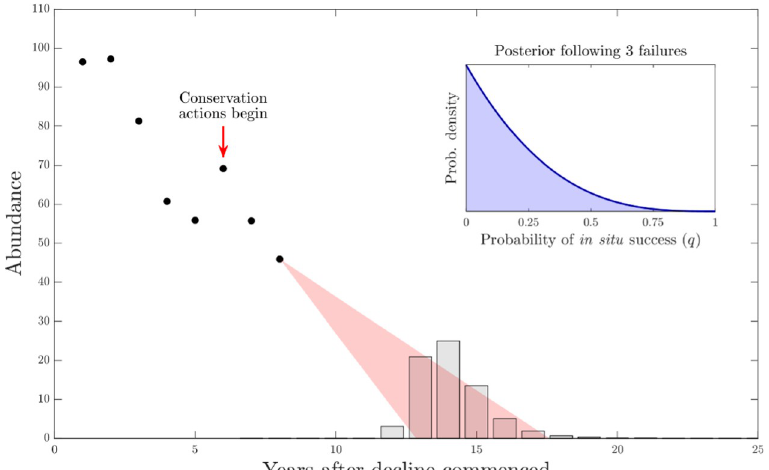
Fig 1. Schematic of an ex situ , in toto decision for a hypothetical single population threatened species (SPTS). The SPTS abundance has been observed to decline at a linear rate for 8 years; extrapolating, the population will likely drop to extinction within 4–10 years. The bars show the probability distribution for the extinction year, based on the range of linear declines shown in red. Conservation actions have been underway for 3 years without success. The inset plot shows the posterior belief distribution in the annual probability of in situ success, after 3 failures of in situ actions have occurred.